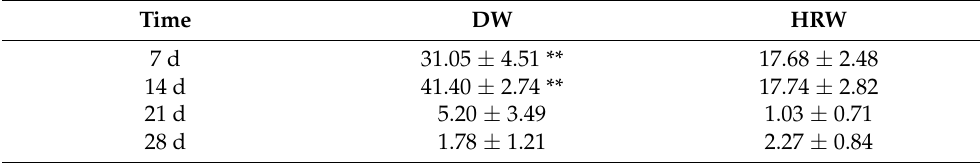
Table 5. The level of MDA (U/mg) in DW and HRW groups at days 7, 14, 21, and 28. ** p <